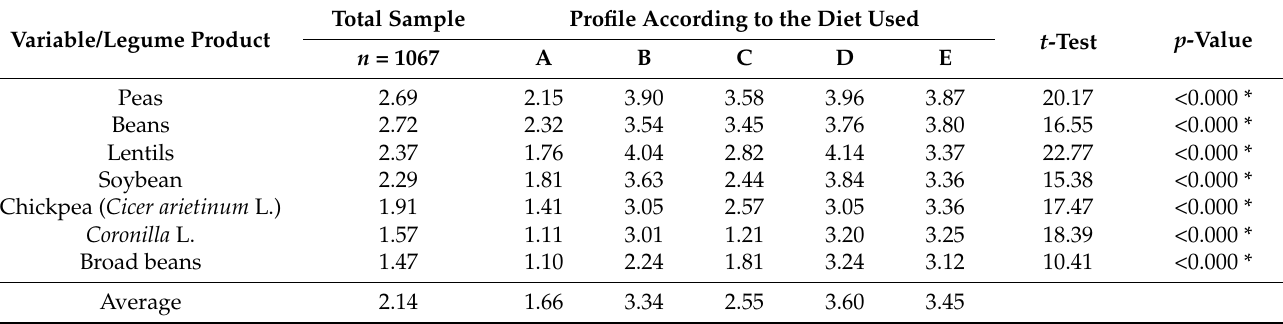
Table 2. The frequency with which meals containing pulses are